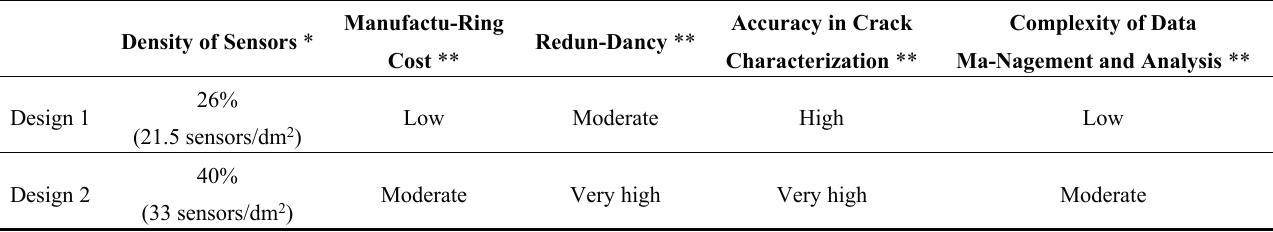
Table 2. Qualitative comparison of sensing sheet Design 1 and Design